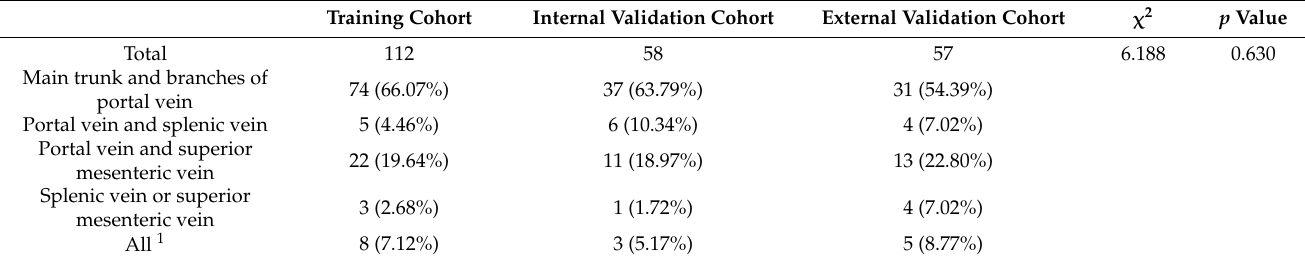
Table 3. The comparison of position of thrombosis in the different cohorts.